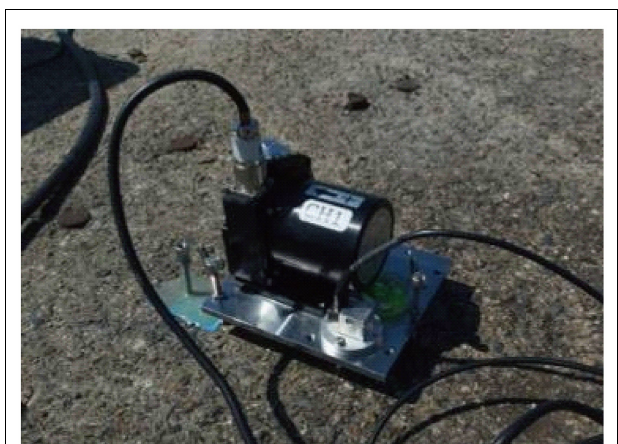
FIGURE 3 | Installation of velocity meter